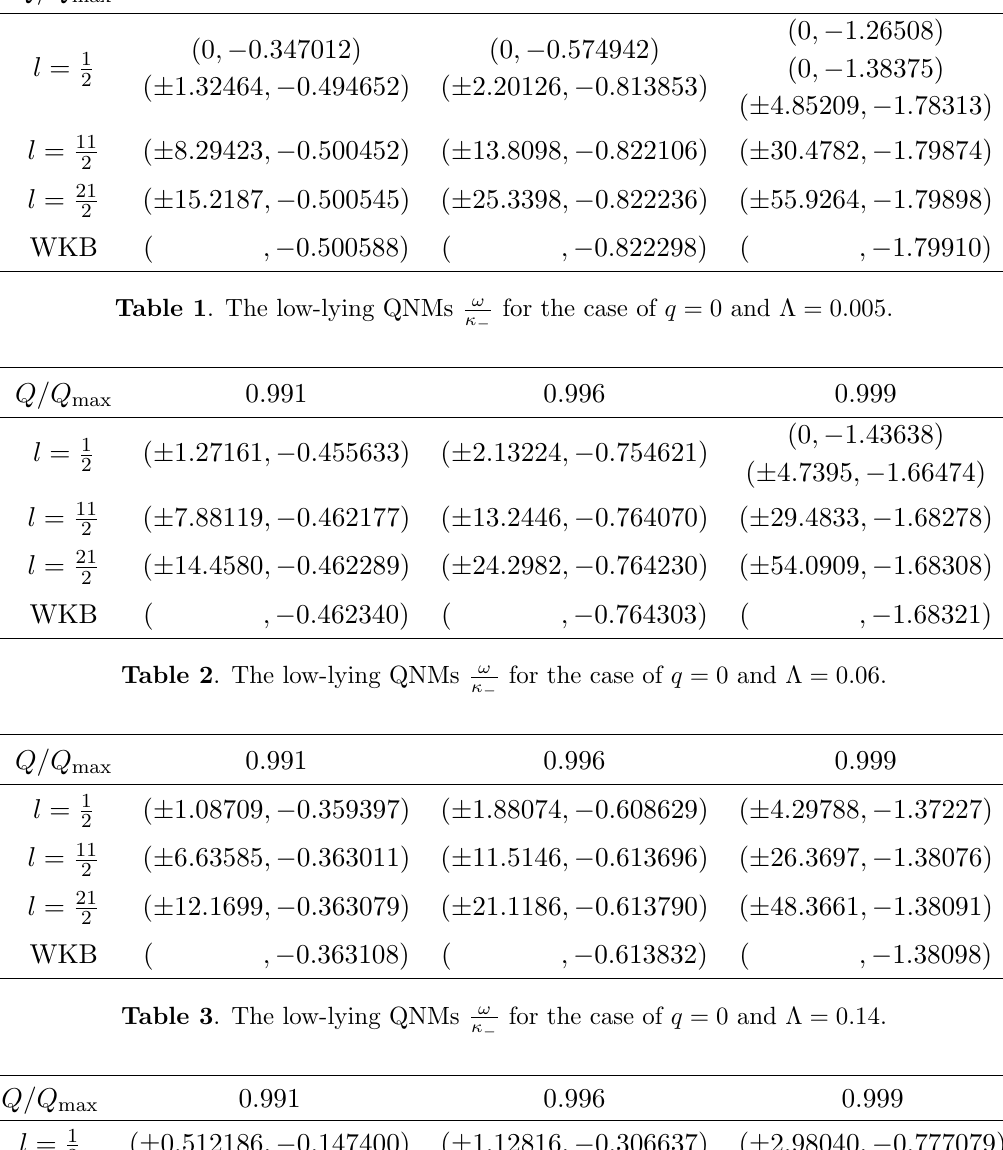
for the case of q = 0 and (cid:3) = 0 : 14. (cid:20) (cid:0)